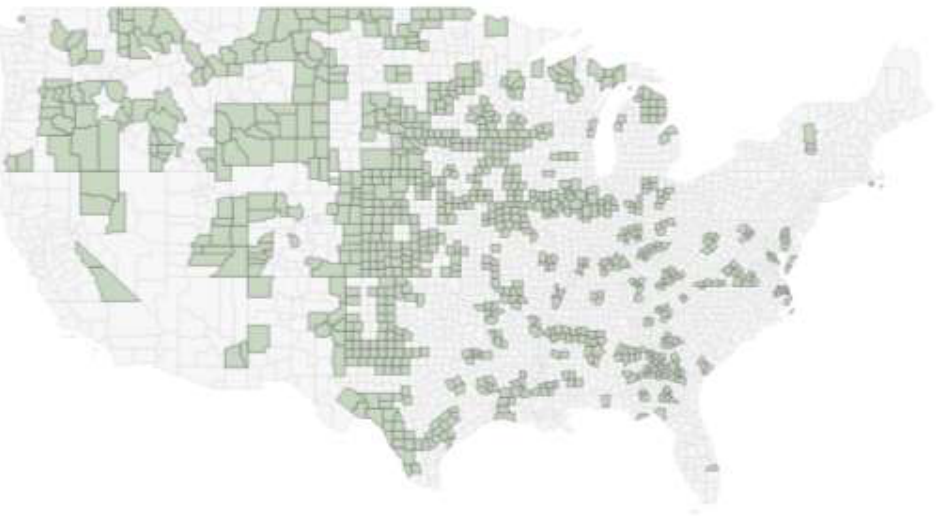
Figure 1. Access deserts in the United States (source: Hillman and Weichman 2016).